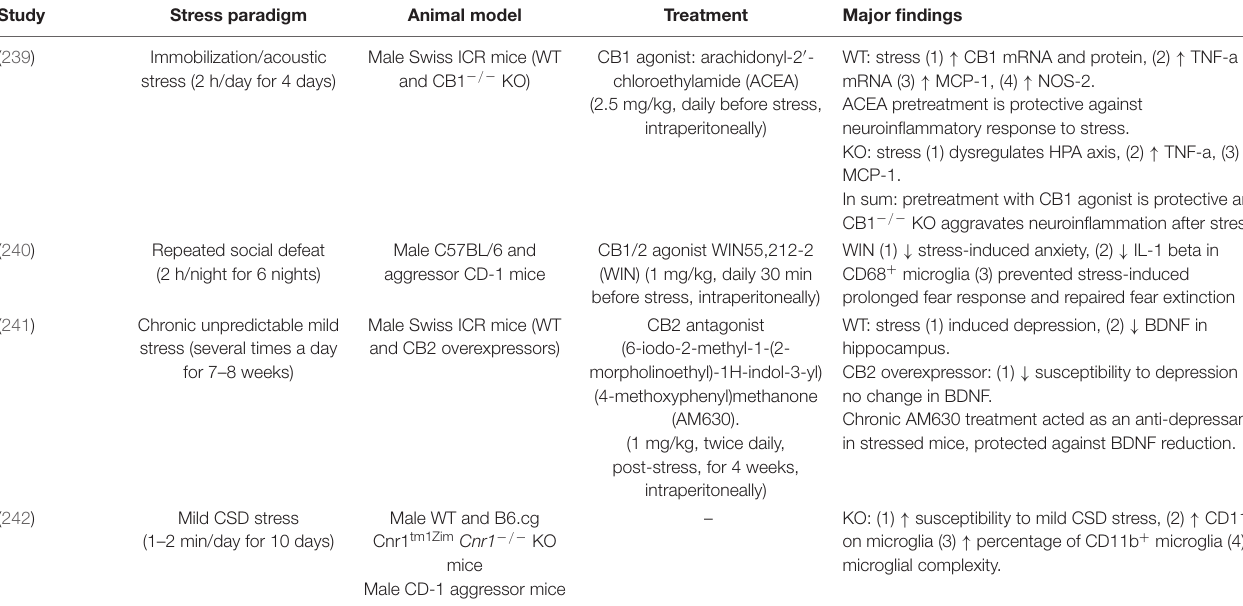
TABLE 3 | Summary of cannabinoid receptors involvement in stress